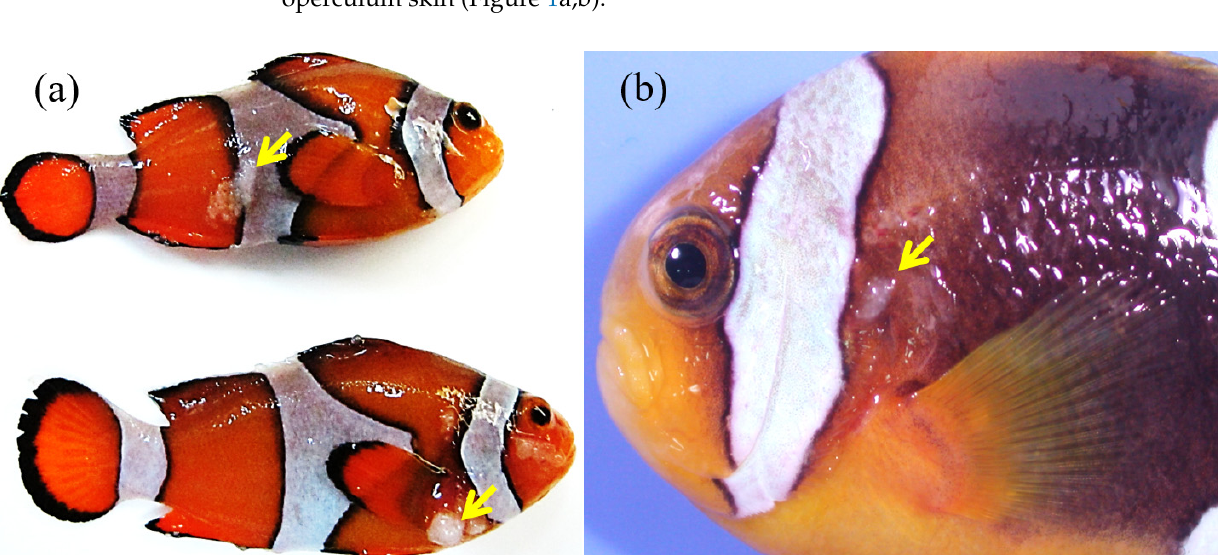
The gill and fin are wreathed by an unusually thick outer membrane, forming a hyaline capsule (Figure 2a,b). The hyaline capsule is shown with a thick and smooth layer covering the hypertrophic lymphocystis cells (Figure 3a,b). The hypertrophic cells are present in various sizes. In addition, the magnified hypertrophic lymphocystis cells showed